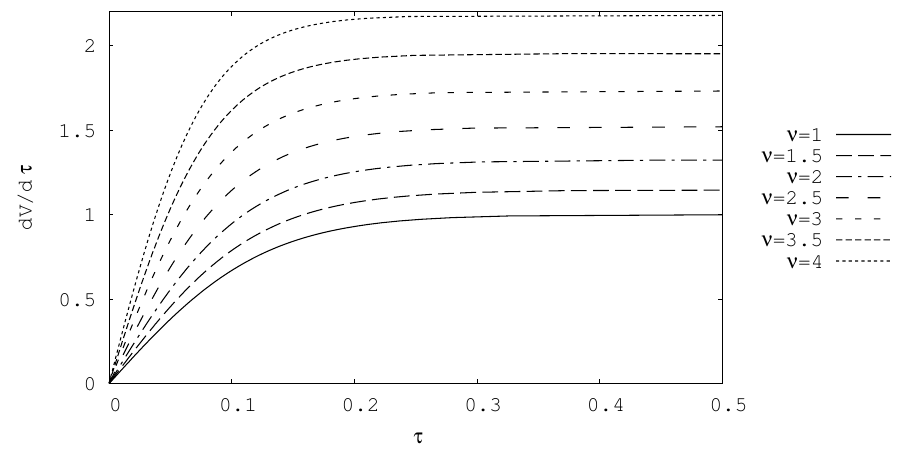
in units of (cid:25)l , for r 0 = 1 and various values of the warping d(cid:28)